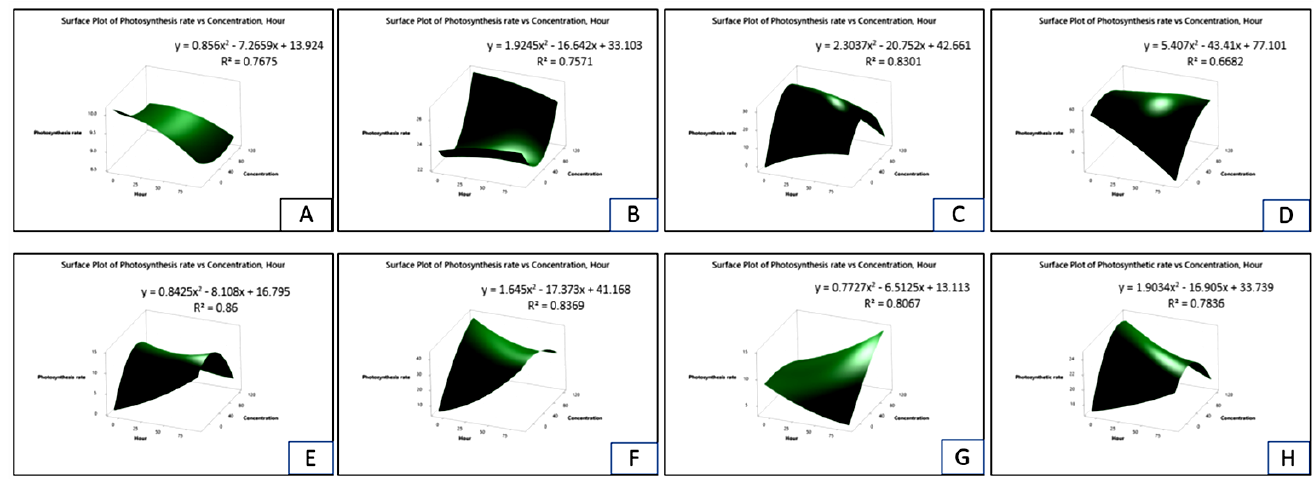
Figure 9. Response surface plot for photosynthesis rate of several crops and weeds due to parthenium leaf methanol extract: ( A ) -Bambara groundnut; ( B ) -Maize; ( C ) - D. sanguinalis ; ( D ) - E. indica ; ( E ) - A. conyzoides ; ( F ) - C. iria ; ( G ) - E. hirta , and ( H ) - C. difformis .